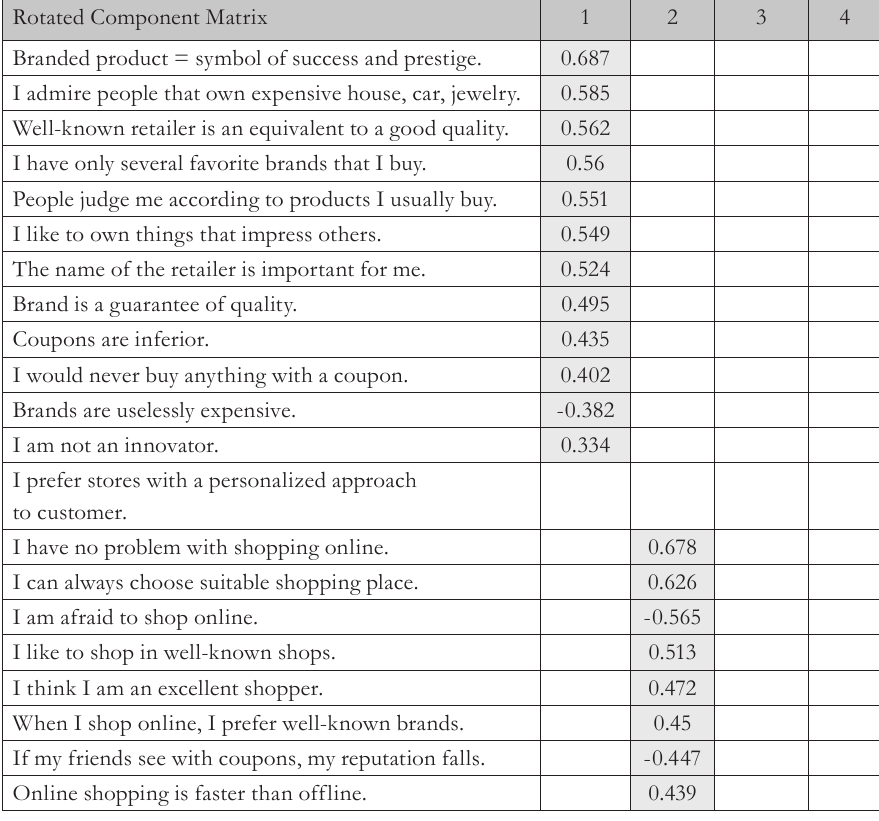
Tab. 6 – Factor Analysis of All Attitudes to Shopping, Brands and Discounts. Source: Author’s